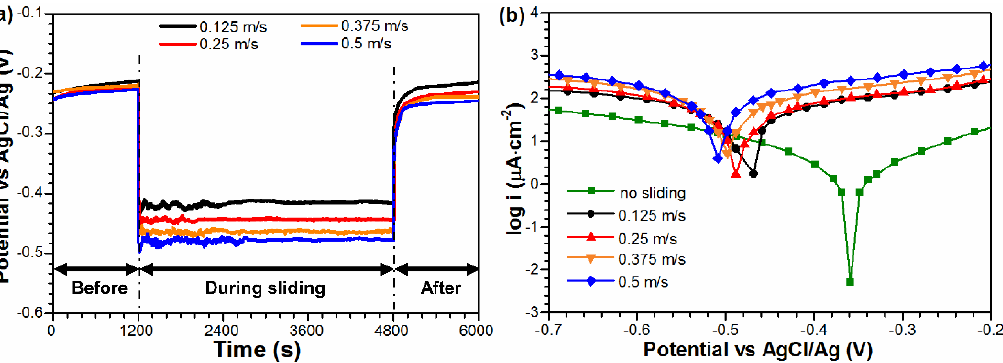
Figure 2. ( a ) Open circuit potential (OCP) curves and ( b ) Tafel curves under different rotational velocities in seawater.